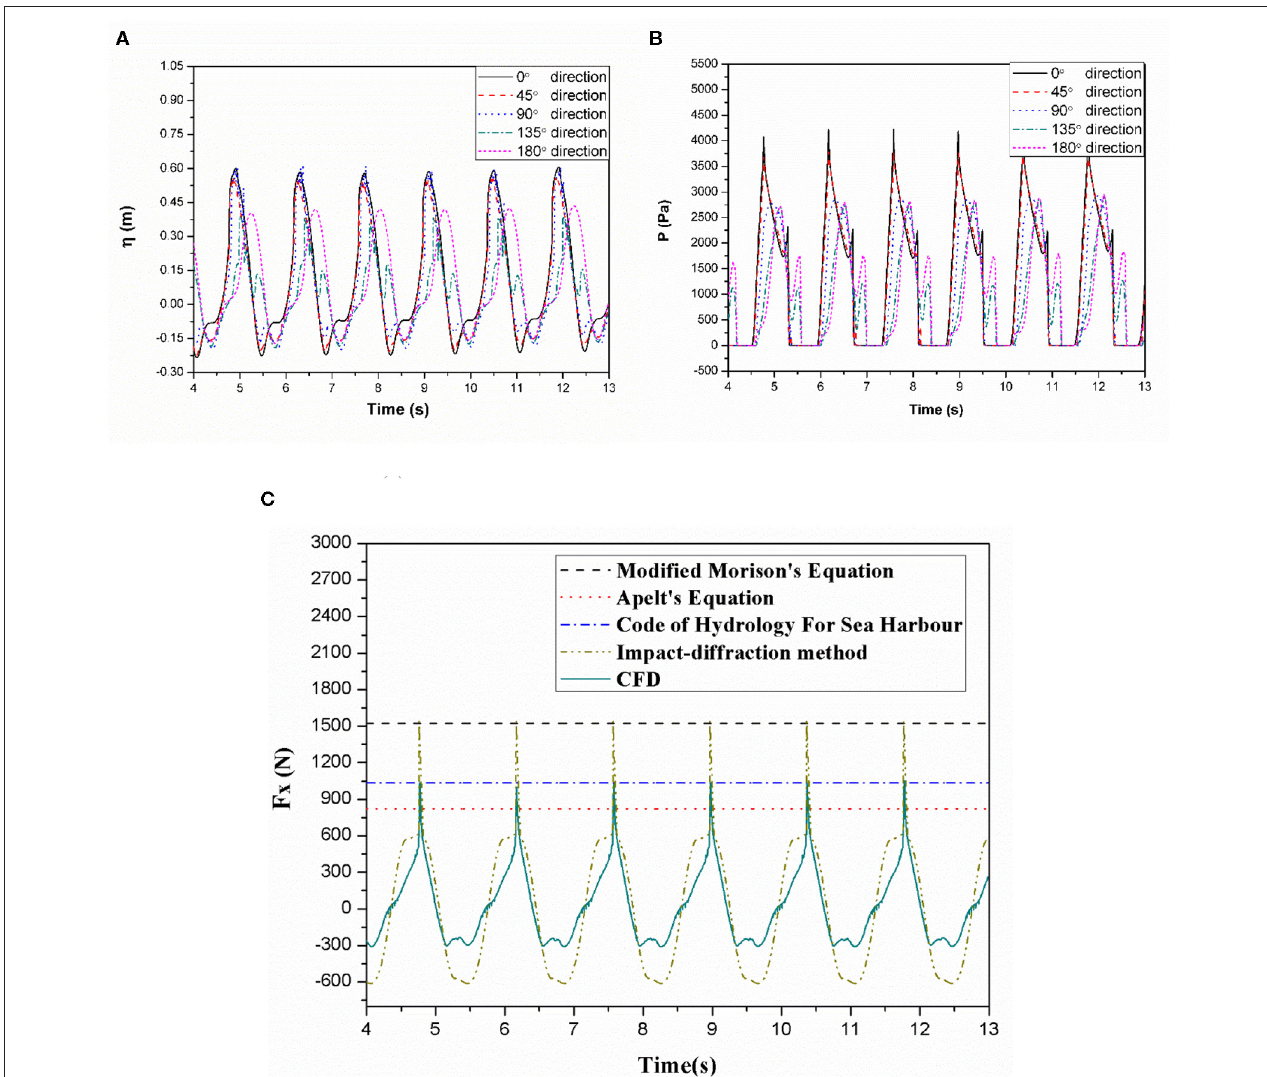
FIGURE 6 | (A) Wave run-up; (B) pressure; (C) wave force ( ξ 0 =